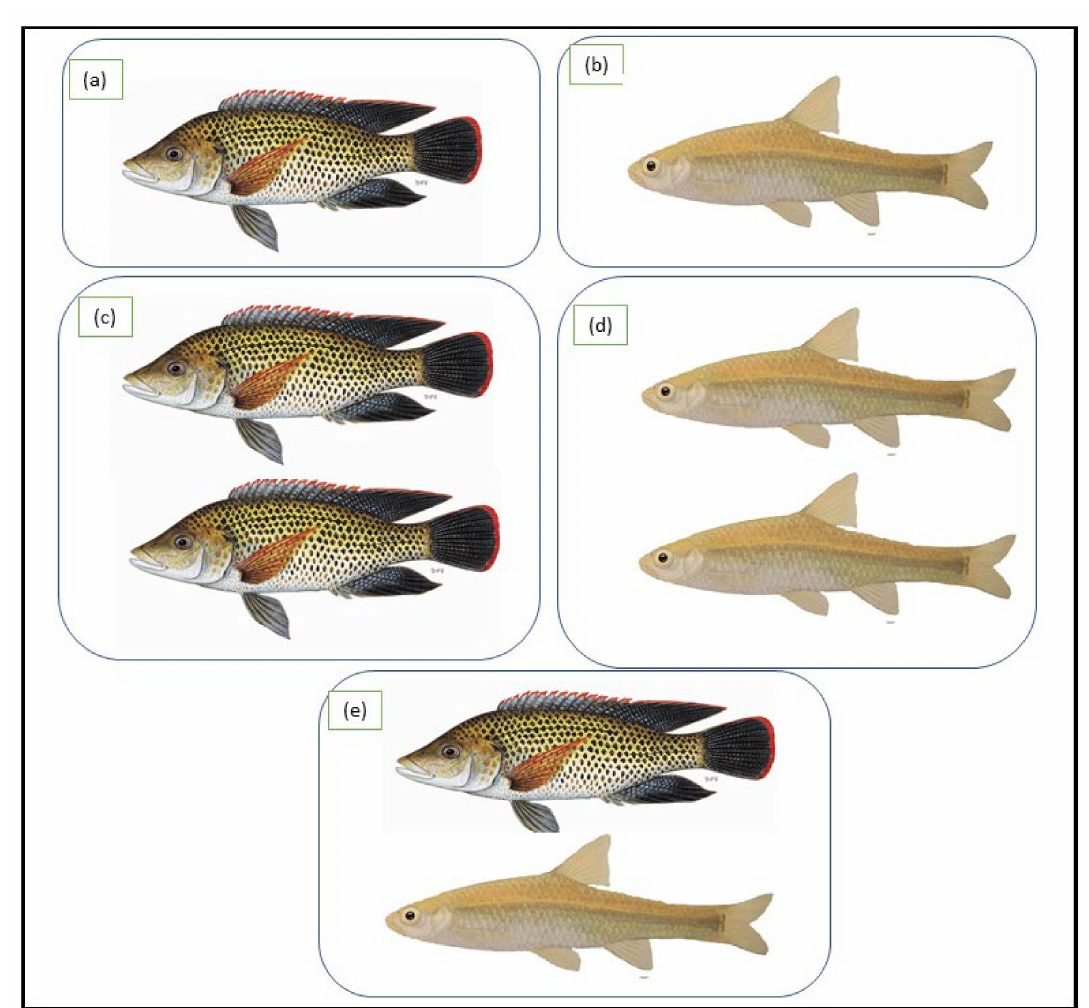
Figure 1. Experimental predator treatments comprising individual predator, conspecific and inter- specific pairs of ( a ) Oreochromis mossambicus ; ( b ) Enteromius paludinosus; ( c ) Oreochromis mossambicus + Oreochromis mossambicus ; ( d ) Enteromius paludinosus + Enteromius paludinosus; ( e ) Oreochromis mossam- bicus + Enteromius paludinosus